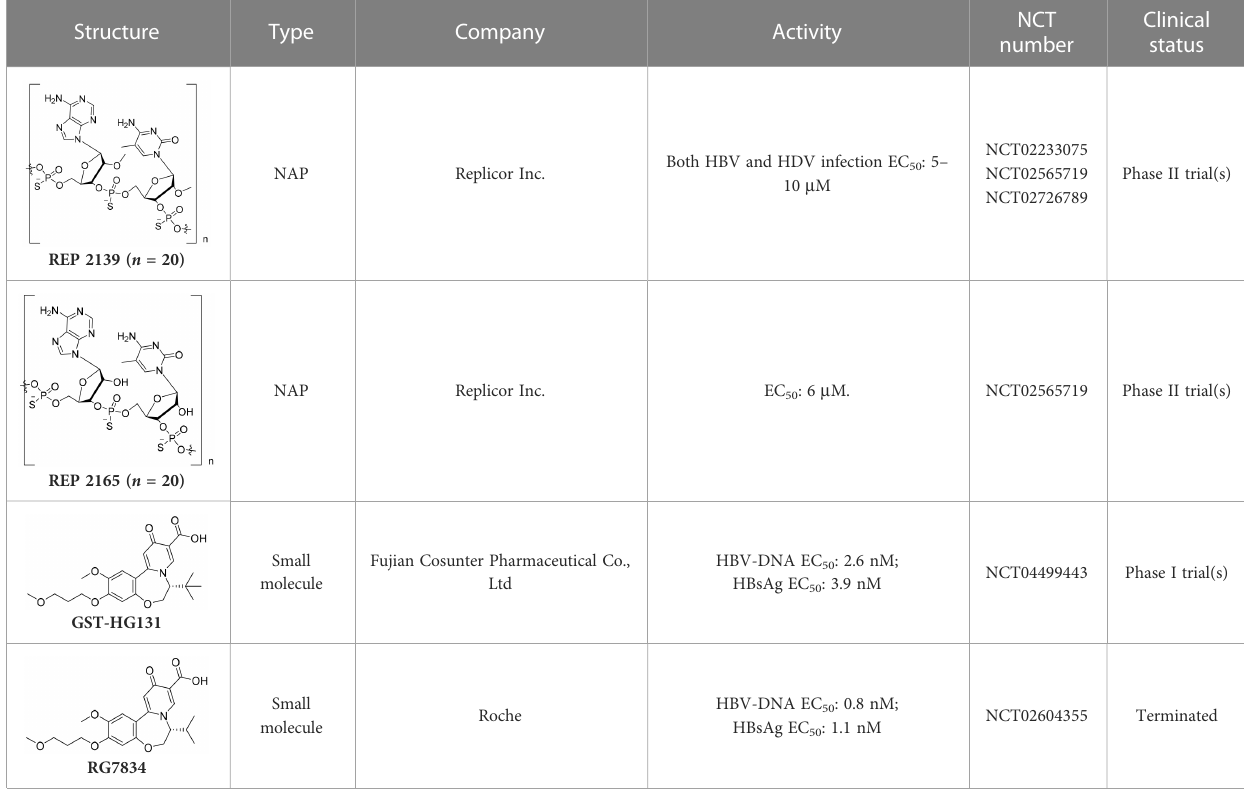
TABLE 6 The summary of molecules inhibiting the release of HBsAgs.